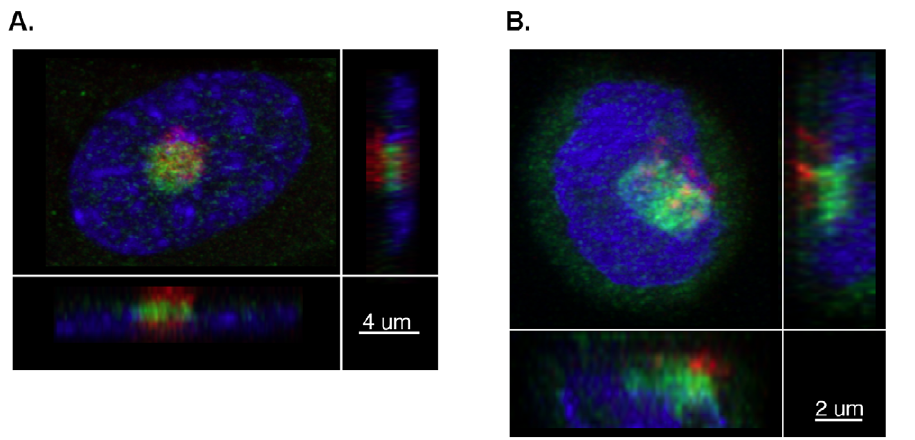
Figure 5. BORIS is adjacent to fibrillarin in the nucleolus. Three-dimensional confocal images showing BORIS staining in green (Alexa 488) and fibrillarin staining in red (Alexa 594). Cells are counterstained with 4 9 , 6-Diamidino-2-phenylindole (DAPI, blue). A , MRC5 fibroblasts and B , C99 colorectal cell line. Images are shown at 63x magnification.